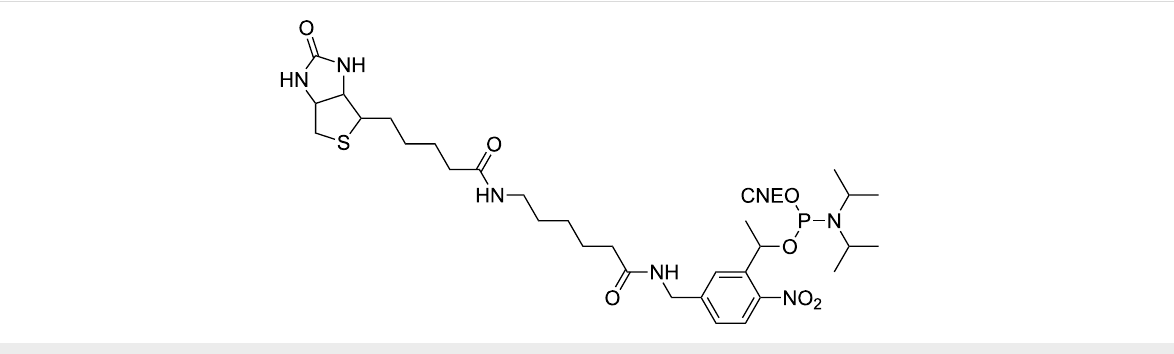
Figure 4: Biotinylated 1-(5-(aminomethyl)-2-nitrophenyl)ethyl phosphoramidite used to cage the 5’-end of a siRNA during its synthesis on solid support using phosphoramidite chemistry